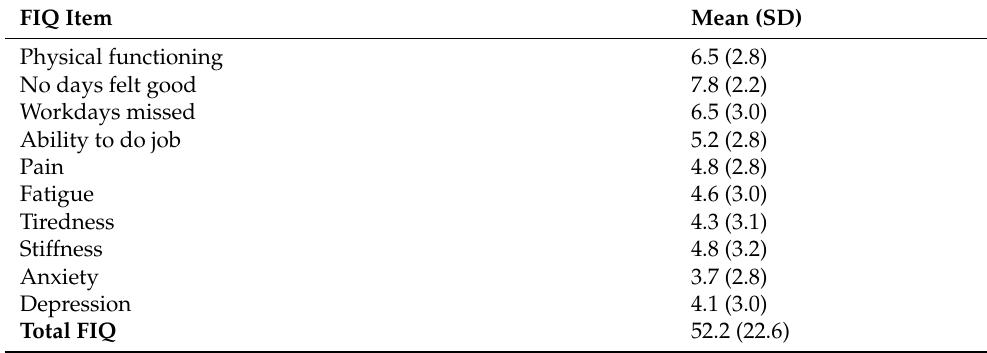
Table 3. Items of FIQ